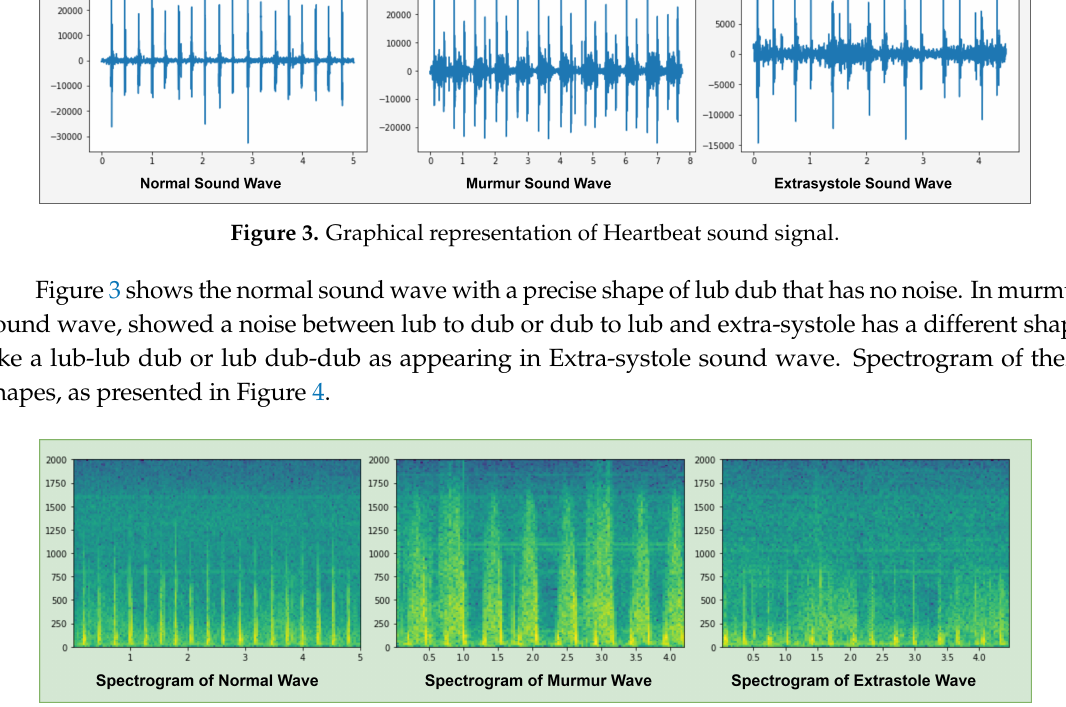
Figure 4. Spectrogram of Heartbeat sound